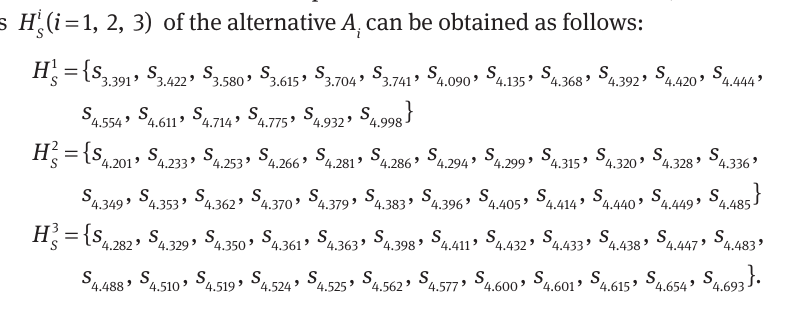
Table 8: Hesitant Fuzzy Linguistic Weighted Matrix H